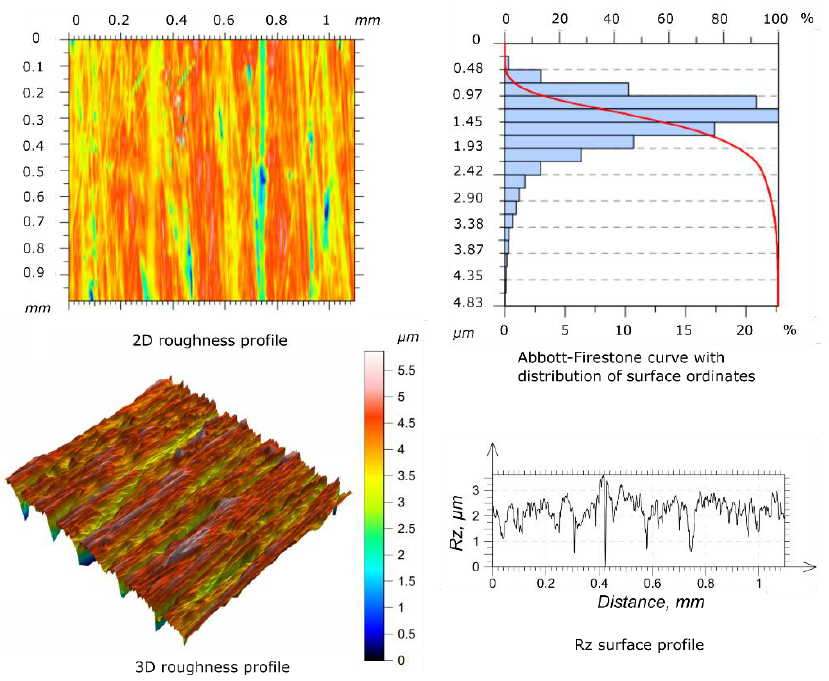
Figure 3. Geometric structure of the surface before the wear tests for specimen.